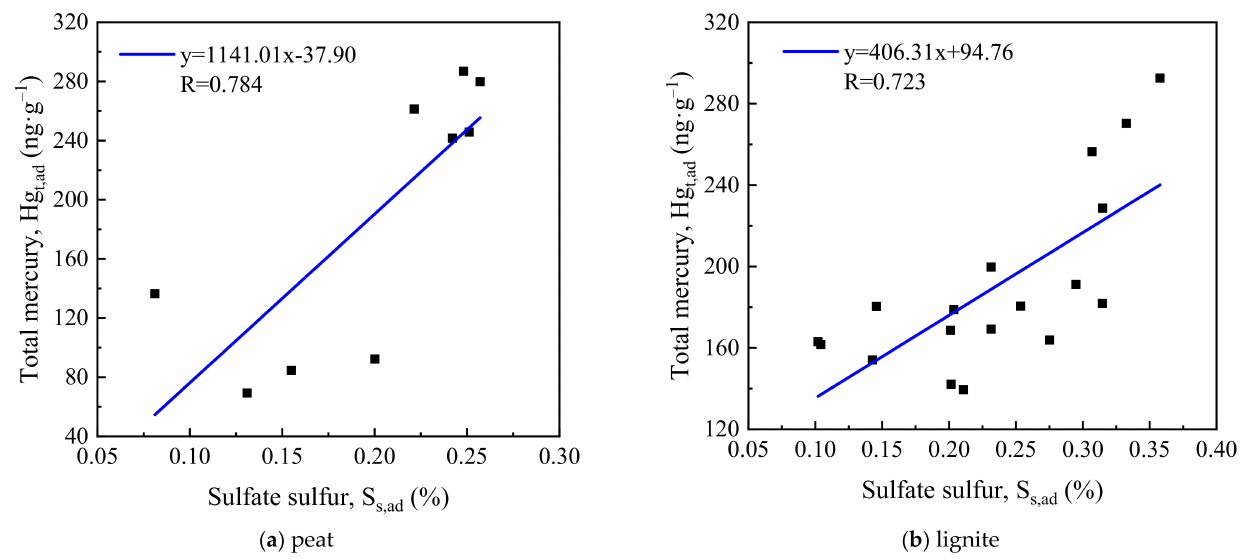
Figure 12. Correlation between Hg and sulfate sulfur for coal samples with different ranks. The correlation between the Hg and pyritic sulfur in different rank coals is shown in Figure 13. It can be found that Pearson linear correlation coefficient is 0.860 in Figure 13a, demonstrating Hg is also significantly correlated with pyritic sulfur in peat. Combining with Figures 6 and 12a, Hg depends on organic sulfur, sulfate sulfur and pyritic sulfur. From Figure 13b–d, the correlation coefficients of Hg and pyritic sulfur in lignite, sub- bituminous coal and bituminous coal are 0.479, 0.709 and 0.887, respectively, which means the dependence of Hg on pyritic sulfur is enhanced with the increase of coalification